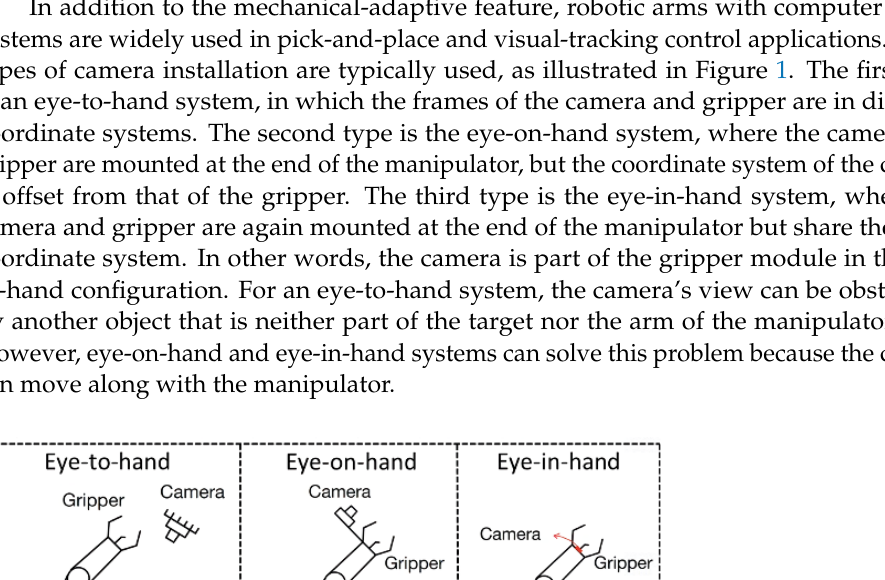
Figure 2. The out-sight problem of the eye-on-hand system with a 10 mm × 10 mm target. In R. Barth’s paper, the main purpose was to find a crop-like berry, which was behind some leaves, and collected by a robot arm with a camera on the manipulator [9]. The cam- era can avoid the leaves and find the crop by moving the manipulator using an eye-on- hand system. In addition to R. Barth’s paper, a substantial number of research studies have used the eye-on-hand configuration to avoid occlusion [10 – 13]. In fact, both eye-in- hand and eye-on-hand configurations can perform intuitive teleoperation tasks using high-DOF servo-manipulators [14]. The camera can obtain images from different angles by controlling the robot because it is mounted at the end of the manipulator for easier calibration of both the camera and manipulator [15 – 17]. Furthermore, should the RGB-D camera be combined with eye-on-hand configuration, calculation of the proper gripping position by the depth gradient feature without different camera shots becomes simple [18]. The primary difference between the eye-on-hand and eye-in-hand configurations is that the coordinates of the camera contain an offset with the center of the gripper in the eye-on-hand system. For the eye-on-hand system, when the gripper approaches the target, the camera is blocked by obstacles or the gripper itself and loses the target while tracking the moving target. In addition, occlusion by the gripper itself can be easily avoided with the eye-in-hand setup, and the eye-in-hand setup is simply calibrated because it is not offset from the gripper’s coordinate system. In this paper, the eye-in-hand configuration was applied in the model robotic gripper in which the controller of the gripper and the visual calculator were integrated inside the gripper, allowing the gripper to become a plug-and-play module. In addition to the me- chanical adaptivity, this eye-in-hand gripper also possessed features, namely visual adap- tivity, by its shape recognize feature for different target objects and visual servoing feature for tracking a moving object, respectively. The sectional view of the gripper is shown in Figure 3. This adaptive gripper contained three main motors for the motion of the three fingers, and two side motors for the finger’s spread angle , each of which operated independently and was controlled by a Raspberry PI computer. The adaptive finger in this gripper was designed with multiple degrees of freedom, but only driven by a single